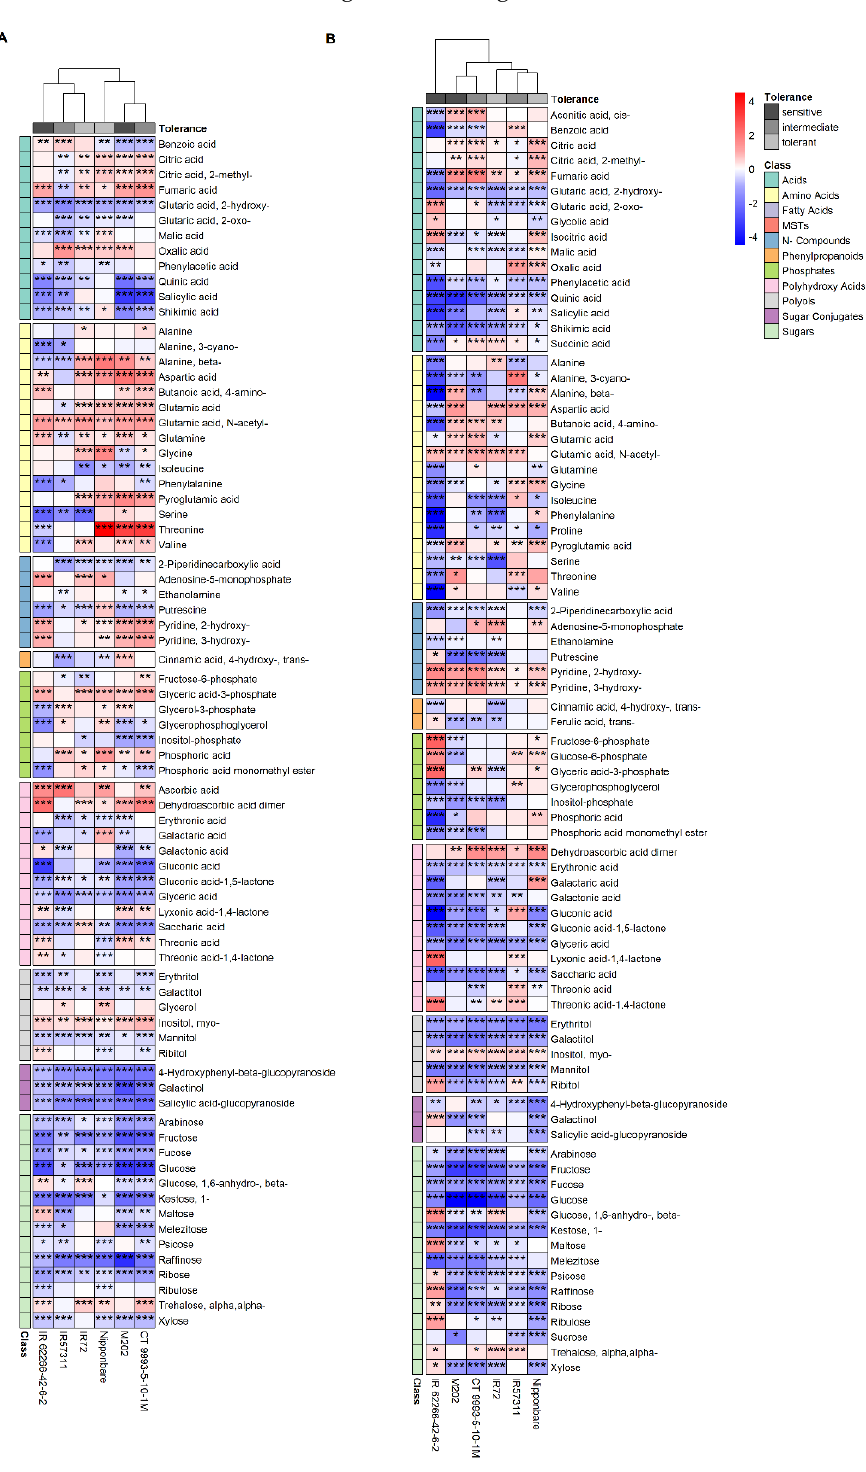
Figure 4. Changes in metabolite levels in leaf middle ( A ) and tip ( B ) segments represented as log 2 fold changes. Red color indicates a higher log 2 fold change, blue color a lower log 2 fold change compared to the control. Asterisks display significance level of p values: <0.001—***, ≥ 0.001 and ≤ 0.01—**, ≥ 0.01 and ≤ 0.05—*. Tolerance and metabolite classes are color-coded. For a better overview, only metabolites with significant changes in at least two cultivars are shown.